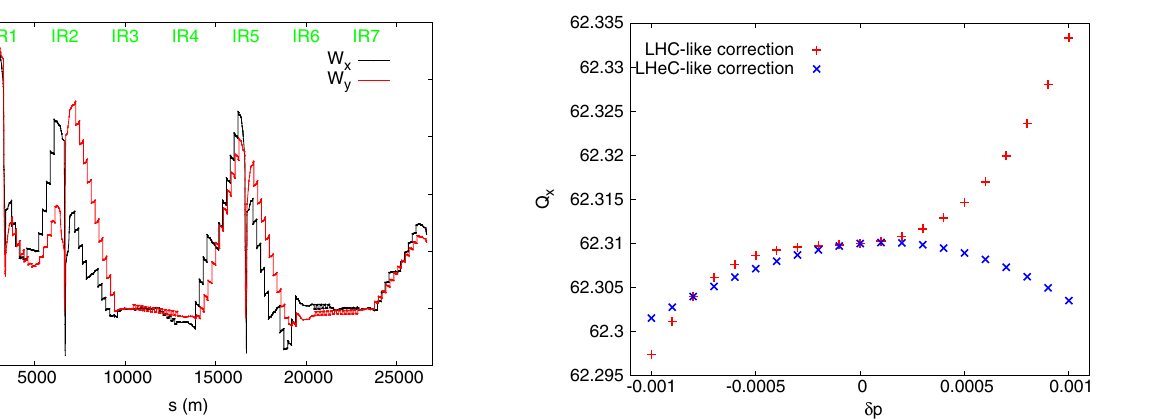
FIG. 10. Horizontal betatron tune Q x vs δ p after the LHC-like and LHeC-like chromaticity corrections.